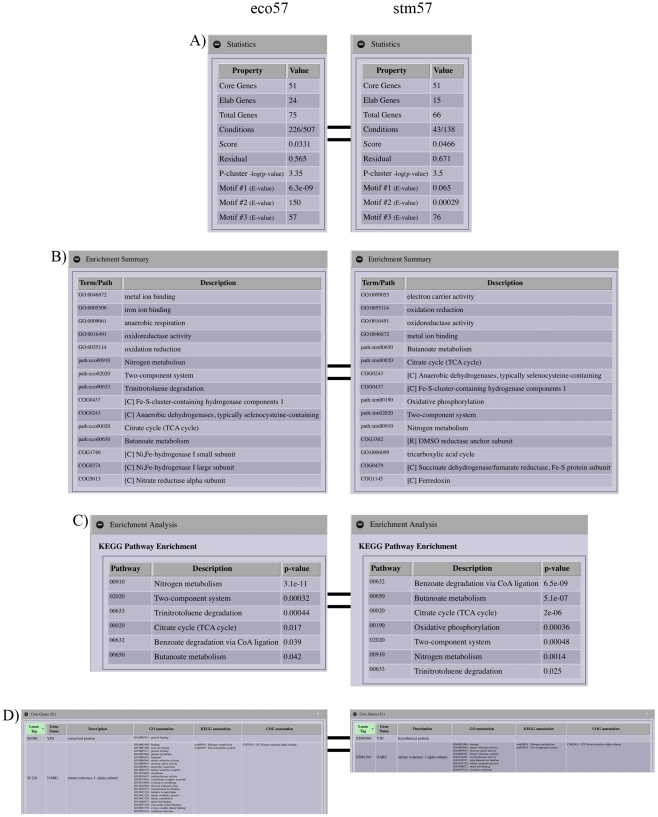
BiclusterCard components I: Statistics, Enrichment Summary, Core Gene Table, KEGG Pathway Enrichment.The BiclusterCard is a summary of the information supporting a bicluster, including links to online tools and source data. Shown in the figure are the expanded tabs for: statistics, enrichment summary from COG, GO and KEGG enrichment analysis, KEGG pathway enrichment, and core gene table for multi-species bicluster E. coli – S. Typhimurium bicluster 57. (A) Statistics tab for eco57 (left) and stm57 (right) displays a table with the following columns: Property and Value. The information contained in this table includes: the number of core and elaborated genes, fraction of conditions in the bicluster, the bicluster score, bicluster residual, bicluster mean p-value (mean of all motifs found in the promoter sequences), and the E-value for each motif found in the bicluster. (B) Enrichment Summary tab for eco57 (top) and stm57 (bottom) displays a table with the following columns: Term/Pathway and Description. This table lists the most significant annotations from ontological enrichment tests of COG, KEGG pathway, and GO annotations. (C) The Functional Enrichment tab displays tables listing the significant annotations from the COG, GO and KEGG enrichment analyses. Shown is the KEGG pathway enrichment table for eco57 (top) and stm57 (bottom). The table consists of the following columns: Pathway, Description, and p-value. Each column can be sorted. (D) Core Gene tab for eco57 (top) and stm57 (bottom), showing the number of core genes (51), and a table containing the following columns: Locus Tag, Gene Name, Description, GO annotations, KEGG annotations, and COG annotations. Locus Tag, Gene Name and Description columns can be sorted.